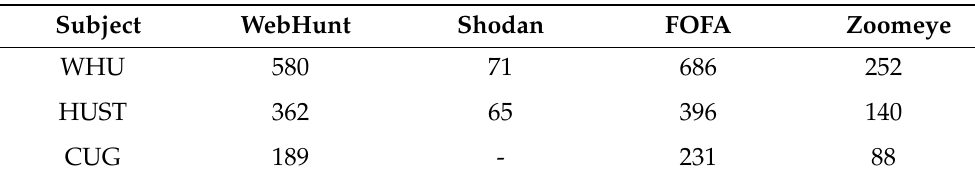
Table 9. Numbers of domain name assets acquired for three universities by WebHunt, Shodan, FOFA and